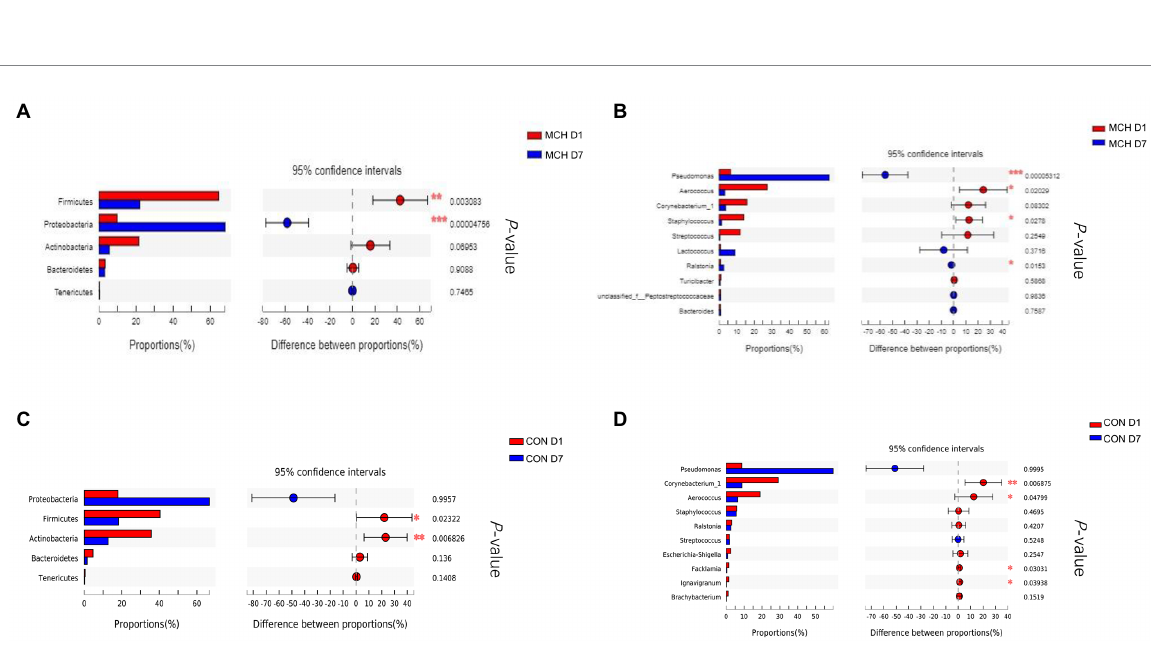
FIGURE 3 Differences in relative abundance of the main bacterial in milk samples on day 1 and day 7 between MCH group and CON group, n = 6. (A) MCH main bacterial phyla. (B) MCH main bacterial genera. (C) CON main bacterial phyla. (D) CON main bacterial